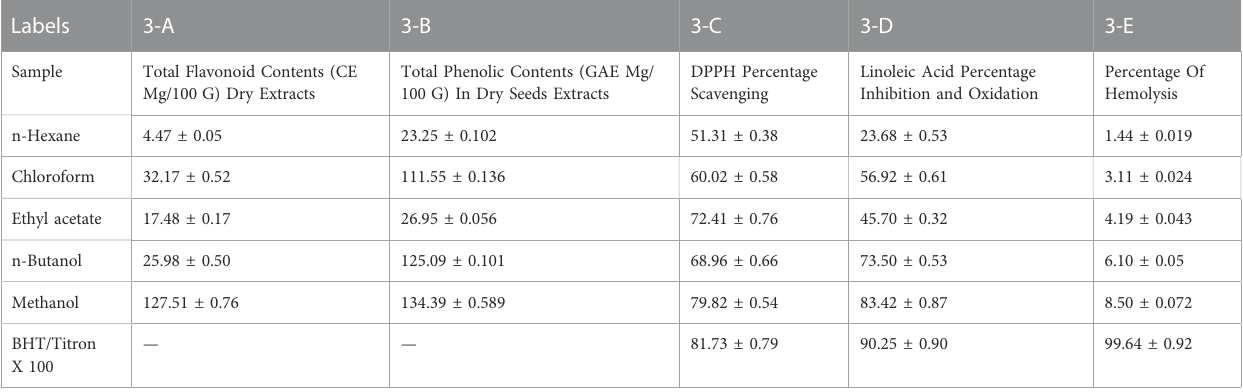
TABLE 3 3 (A) explore the Total fl avonoid contents, 3 (A) Total phenolic contents, 3 (B) Total phenolic contents, 3 (C) DPPH percentage scavenging assay, 3 (D) linoleic acid percentage inhibition and oxidation and 3 (E) explore the hemolytic activity in the percentage of hemolysis in extracts of Amomum subulatum seeds